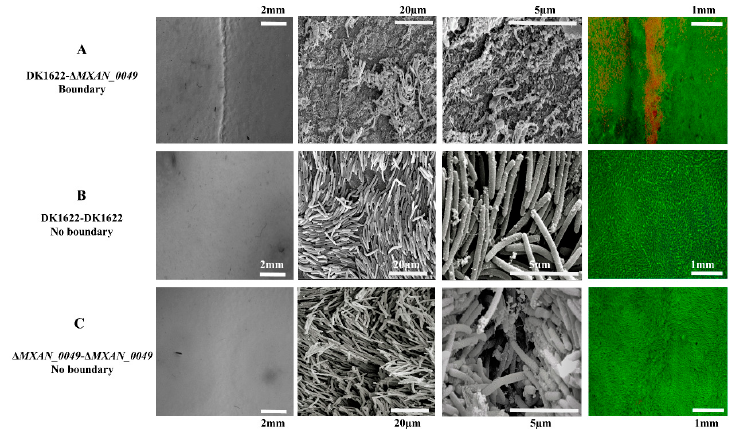
Figure 1. Status of boundary cells by LIVE/DEAD cell viability assay and SEM. At different magnifications, we observed the status of the cells at the point of interaction between DK1622 and